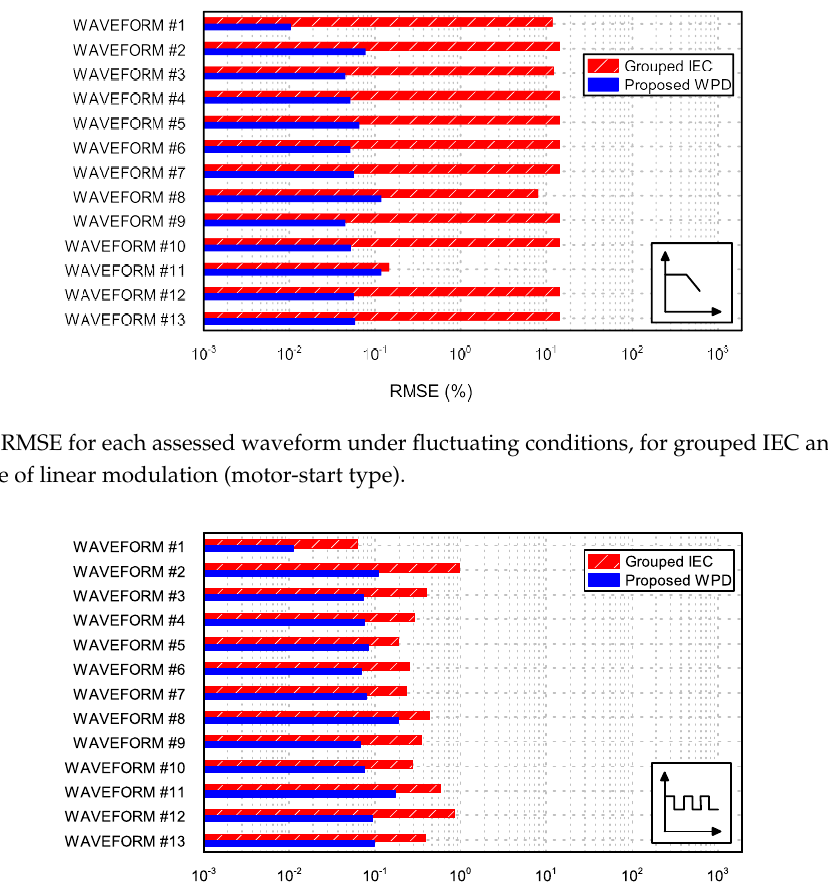
Figure 7. RMSE for each assessed waveform under fluctuating conditions, for grouped IEC and WPD, in the case of constant modulation.